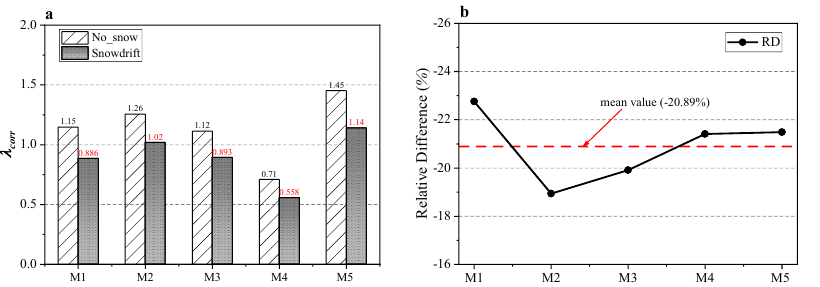
Figure 20. Comparison of the integral length scale of spanwise correlation between no snow and snowdrift roof (( a ) values of the integral length scale of spanwise correlation; ( b ) distributions of Relative Difference. The red dash line represents the mean value of Relative Difference).